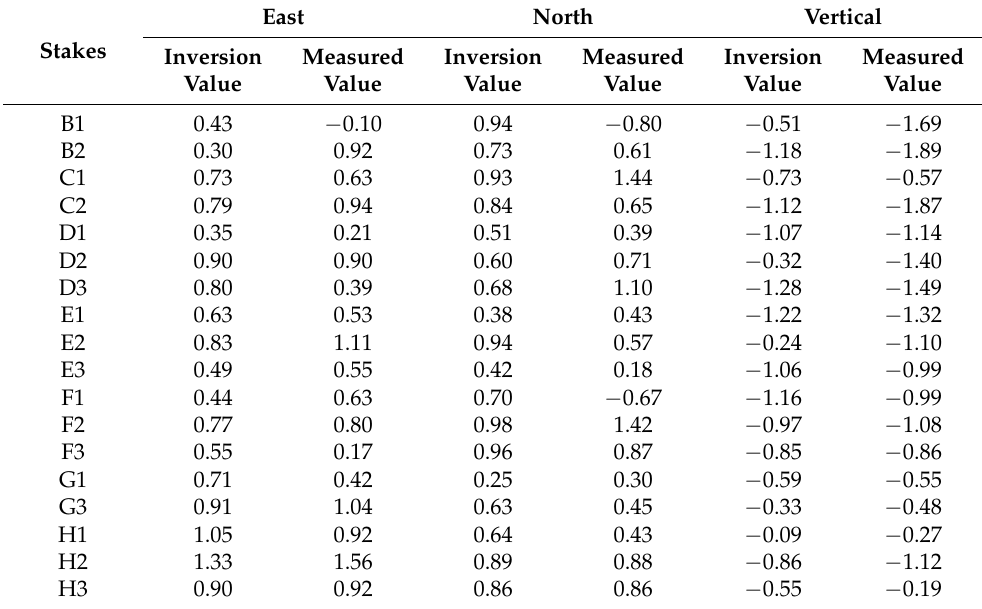
Table 2. The inversion value and the measured value of UG1W in three directions (unit: m).